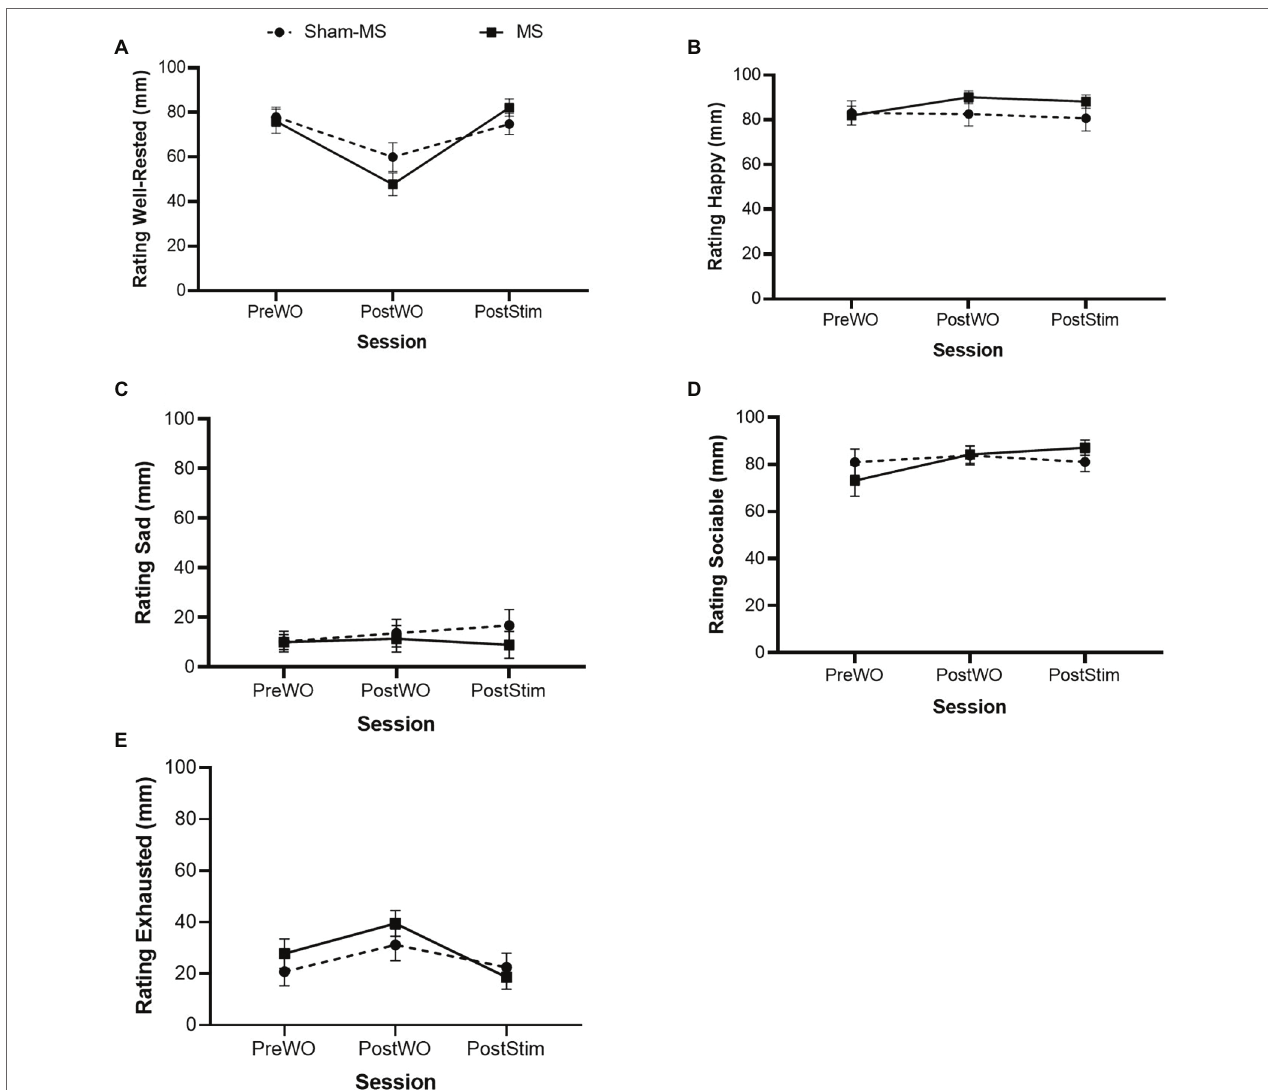
FIGURE 3 | Self-rated mood states (mean and SE) in the Sham-MS and MS condition in the Pre-WO, Post-WO, and Post-Stim sessions. (A) : Well-rested, (B) : Happy, (C) : Sad, (D) : Sociable, (E) :